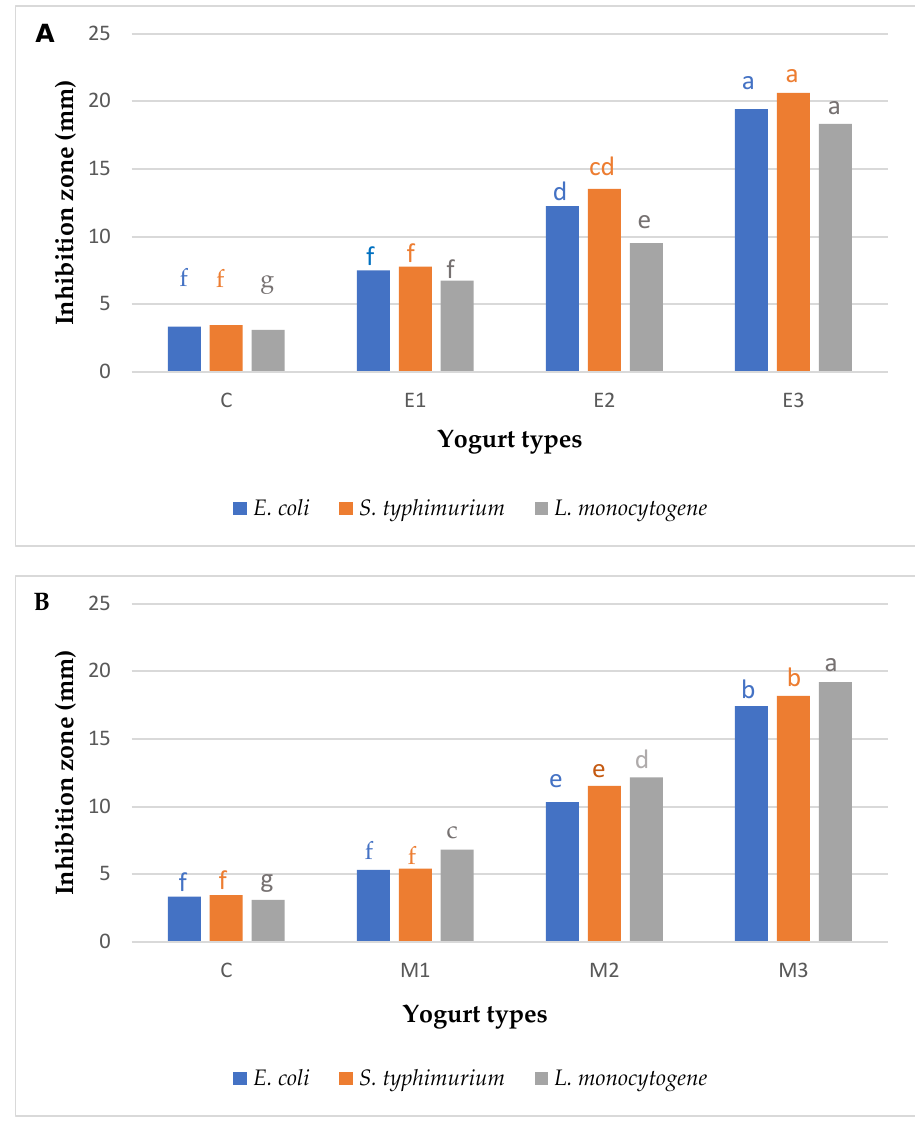
Figure 1. Antibacterial activity of plain yogurts and yogurts supplemented with Eucalyptus ( A ) and Myrrh ( B ) oil during cold storage. C: plain yogurt, E1: yogurt fortified with 0.3% Eucalyptus oil, E2: yogurt fortified with 0.6%, Eucalyptus oil, E3: yogurt fortified with 0.9% Eucalyptus oil, M1: yogurt fortified with 0.3% Myrrh oil, M2: yogurt fortified with 0.6%, Myrrh oil, M3: yogurt fortified with 0.9% Myrrh oil. Mean ± SD with different superscripts (small alphabet a, b, c, d, e, f, and g) differ significantly ( p < 0.5).